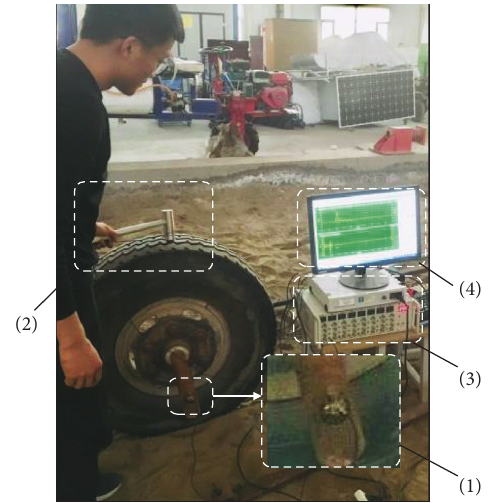
Figure 5: Schematic diagram of hammering test. (1) Acceleration sensor; (2) force hammer sensor; (3) signal amplification and acquisition equipment; (4) computer